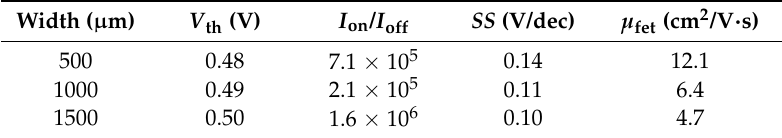
Table 3. The performance parameters of a -IGZO TFTs with Ta 2 O 5 gate dielectric. Width ( µ m) V th (V) I on / I off SS